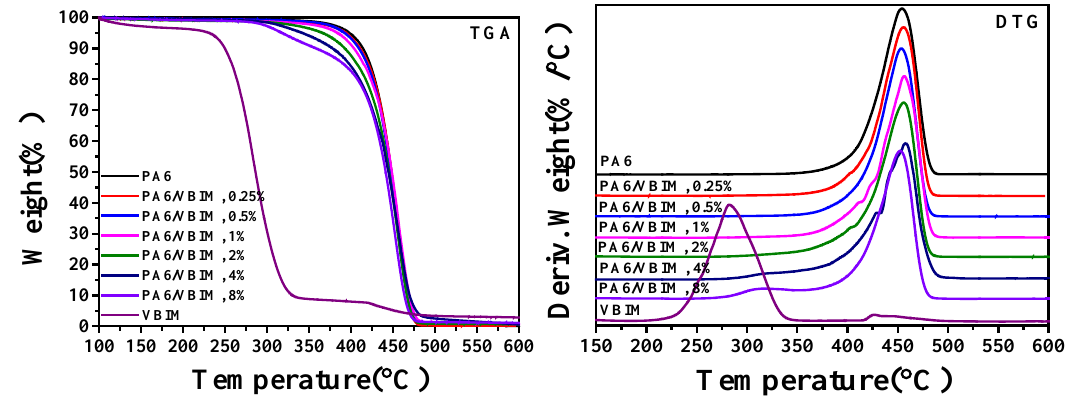
Figure 5. The TGA and DTG curves of neat PA6 and the PA6/VBIM blends.